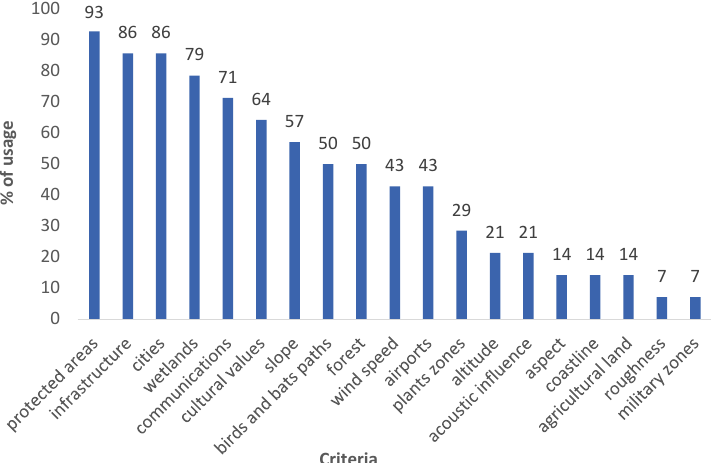
Figure 8. Frequency of criteria used in previous studies.